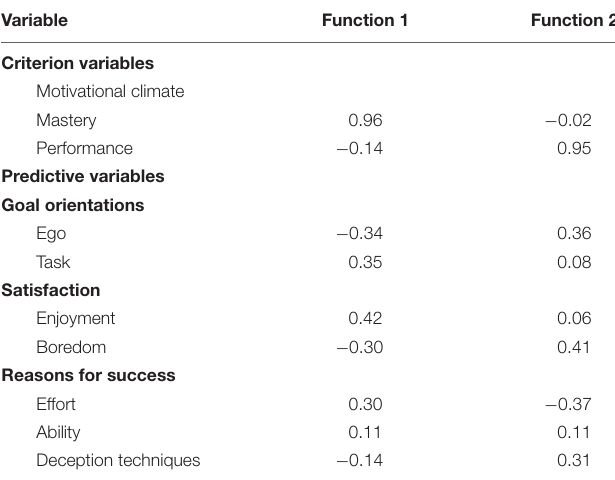
TABLE 3 | Canonical loadings recorded between perceived motivational climate and goal orientation, satisfaction, or reasons for